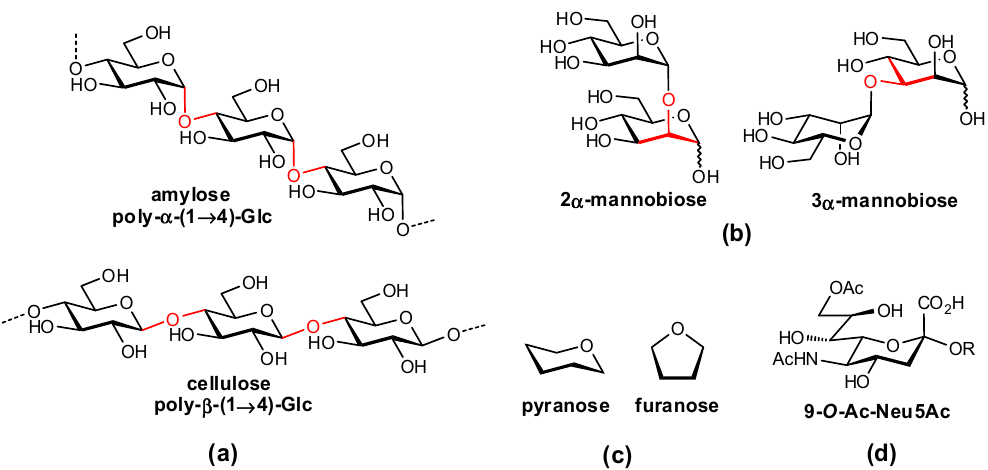
Figure 1. Structural variation in glycans arises from differences in: ( a ) anomeric stereochemistry; ( b ) regiochemistry of linkages; ( c ) ring size; and ( d ) further covalent modifications.